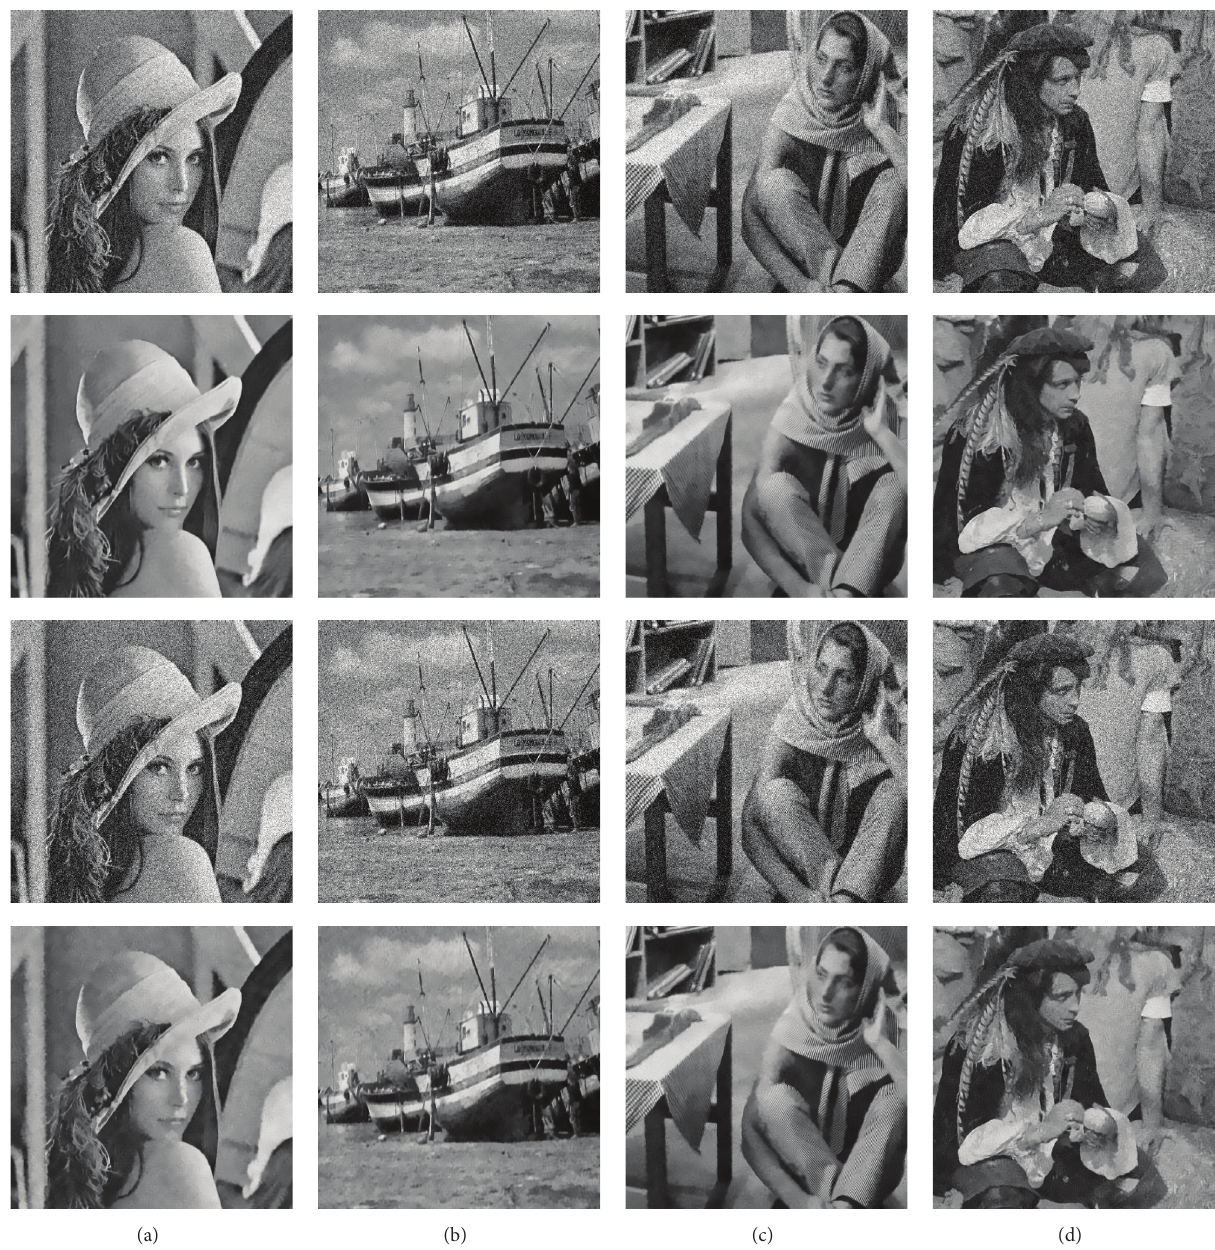
Figure 2: Denoising results by the proposed approach with 𝜎 = 30, 40 . (a), (b), (c), and (d) are Lena , Boat , Barbara , and Man , respectively. The first two rows are the noisy images corrupted by additive Gaussian with 𝜎 = 30 and the corresponding denoising result, and last two rows are noise image with 𝜎 = 40 and the corresponding denoising